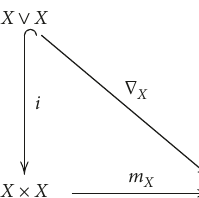
Figure 15: A commutative diagram.